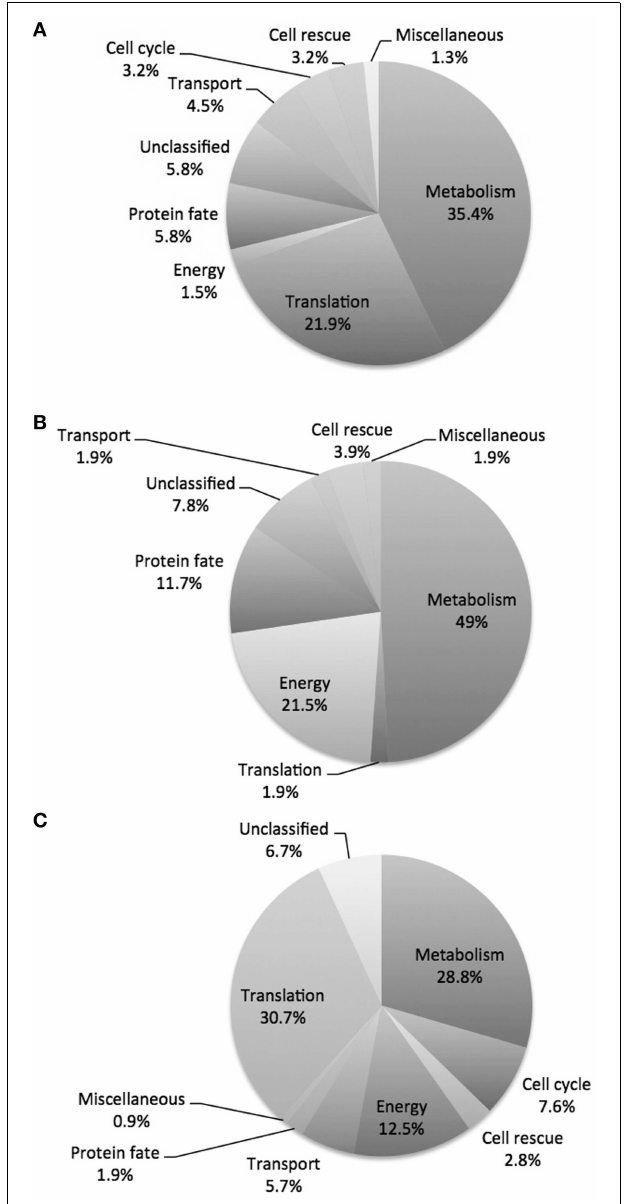
FIGURE 4 | Diagram depicting the breakdown of P. lutzii proteins. (A) Proteins differentially expressed in the absence and presence of argentilactone; (B) More abundant proteins in the presence of argentilactone; (C) Less abundant proteins in the absence of argentilactone.